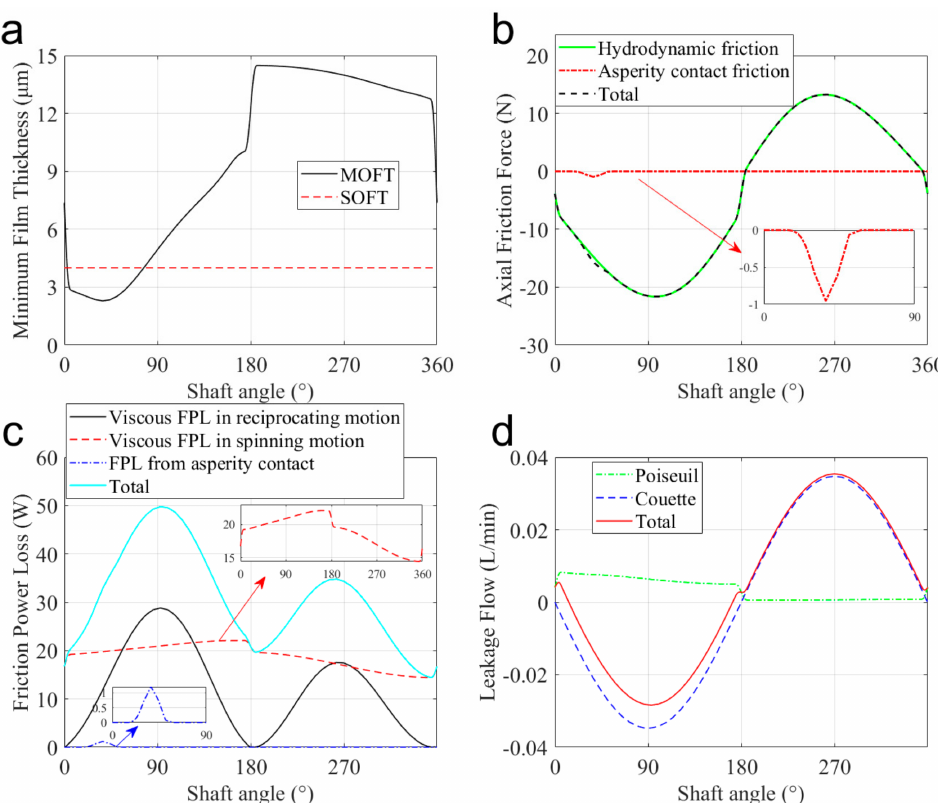
Figure 11. Tribological performances of the piston/ cylinder interface over 1 revolution: ( a ) minimum oil film thickness, ( b ) axial friction force, ( c ) friction power loss, and ( d ) leakage